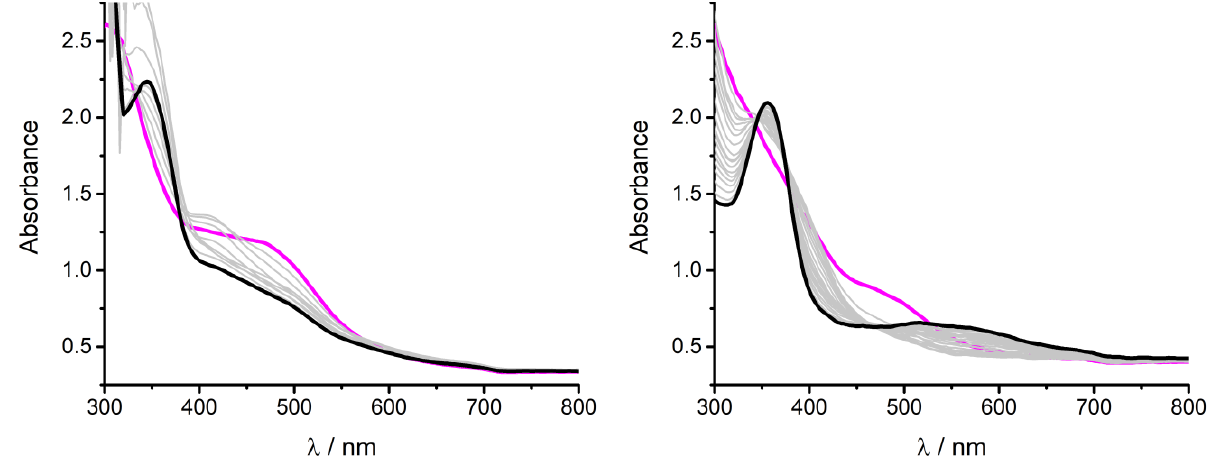
Figure 7. SEC-UV/Vis traces of Fe(salen)Cl under N 2 atmosphere in the presence of 0.5 M PhOH ( left ) and 0.3 M TFE ( right ) proton donors, at the potentials corresponding to the generation of the formal Fe I state (−2.21 V vs. Fc + /Fc).